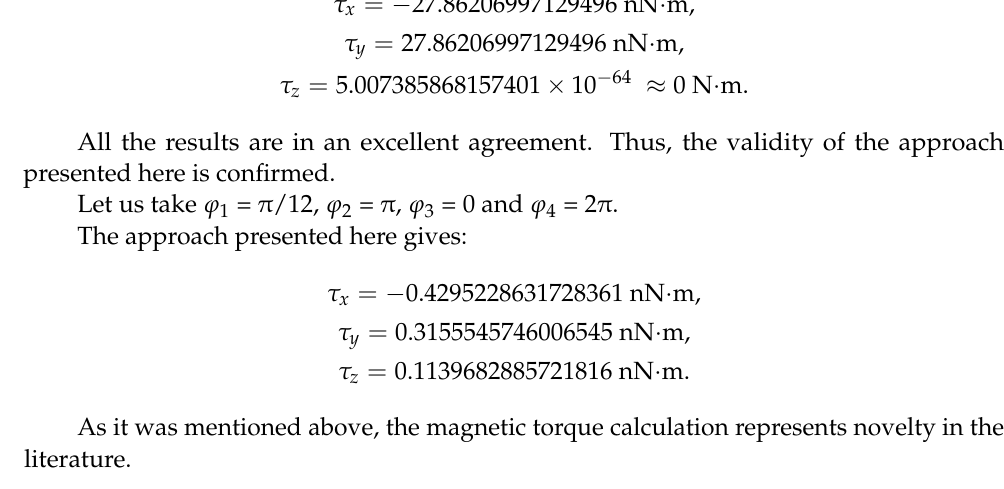
Figure 6. Case (b): two perpendicular circular loops. Not a singular case, ( a = 1, b = c = 0, L = l = 1). Figure 7. Case (c): two perpendicular circular loops. Not a singular case, ( a = 1, b = c = 0, L = l = 1). (c) C (0 m ; 0 m ; 0 m )